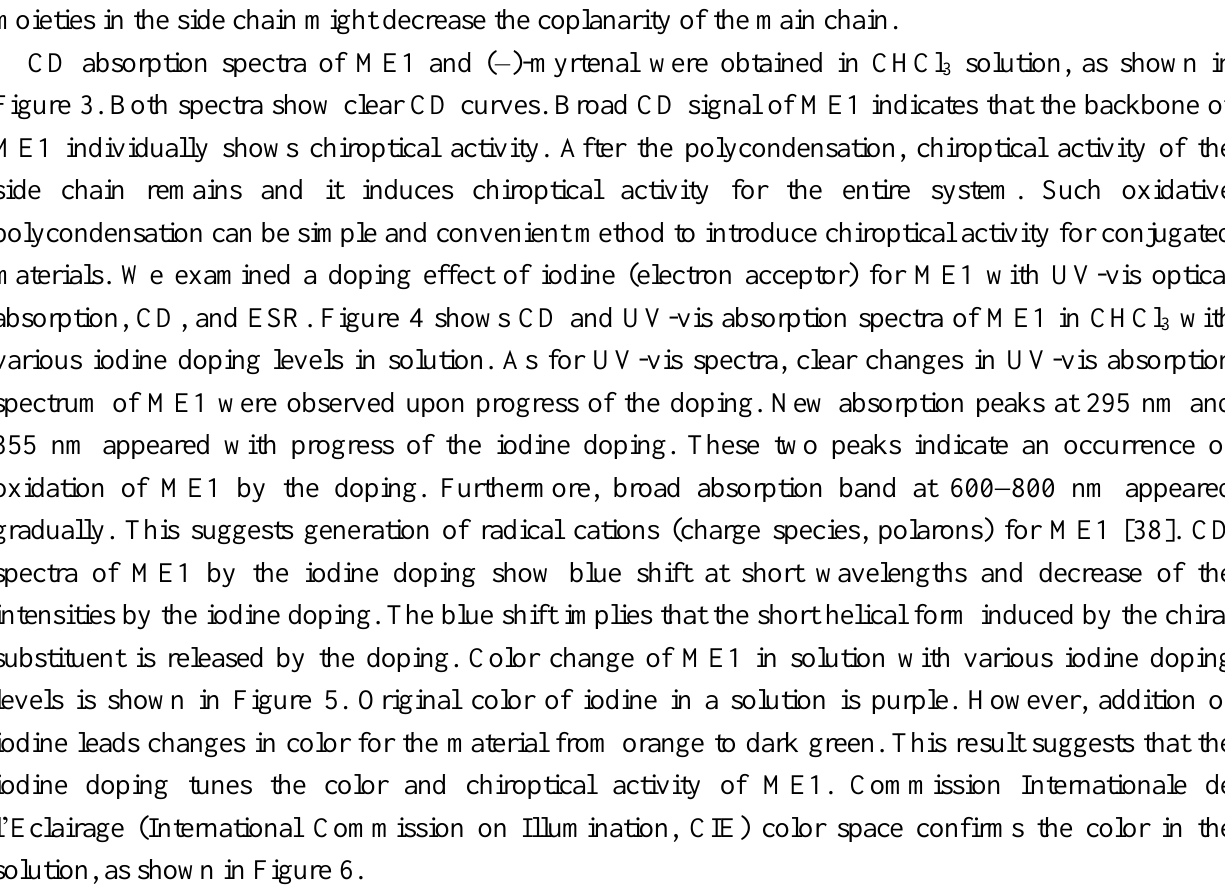
with various iodine 3